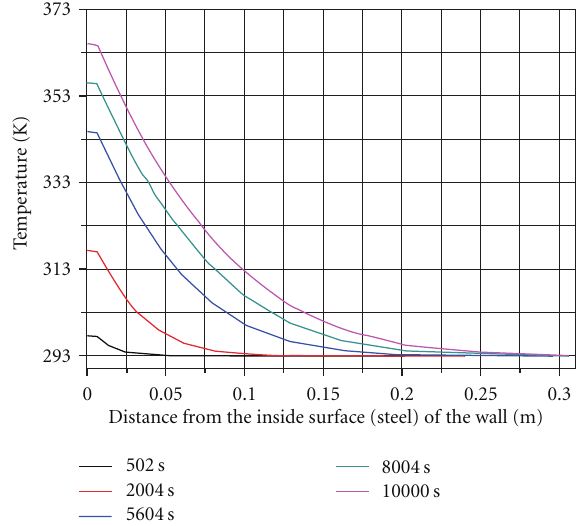
Figure 6: Temporal variations of the through-the-thickness tem- perature profile of the inner containment wall during accidental steam-hydrogen mixture